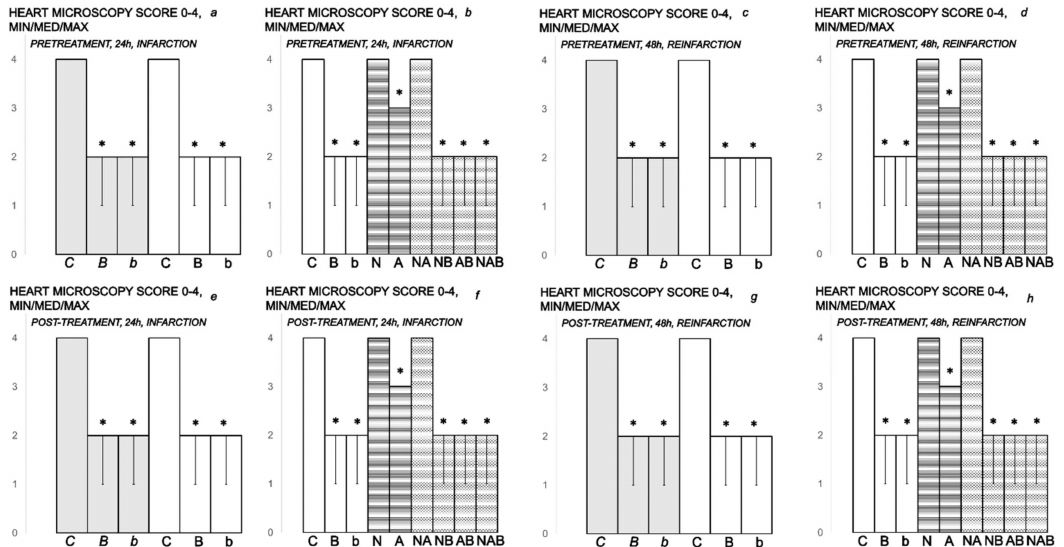
Figure 13. Myocardial infarction (one isoprenaline challenge) and re-infarction (two isoprenaline subsequent challenges) in isoprenaline-treated rats (75 mg/kg sc (gray bars), 150 mg/kg sc (white